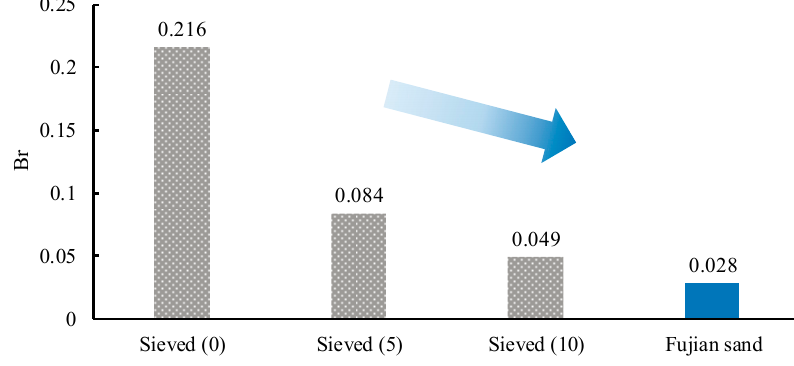
Figure 6. Breakage index of the rubber–calcareous sand mixtures and the Fujian sand.